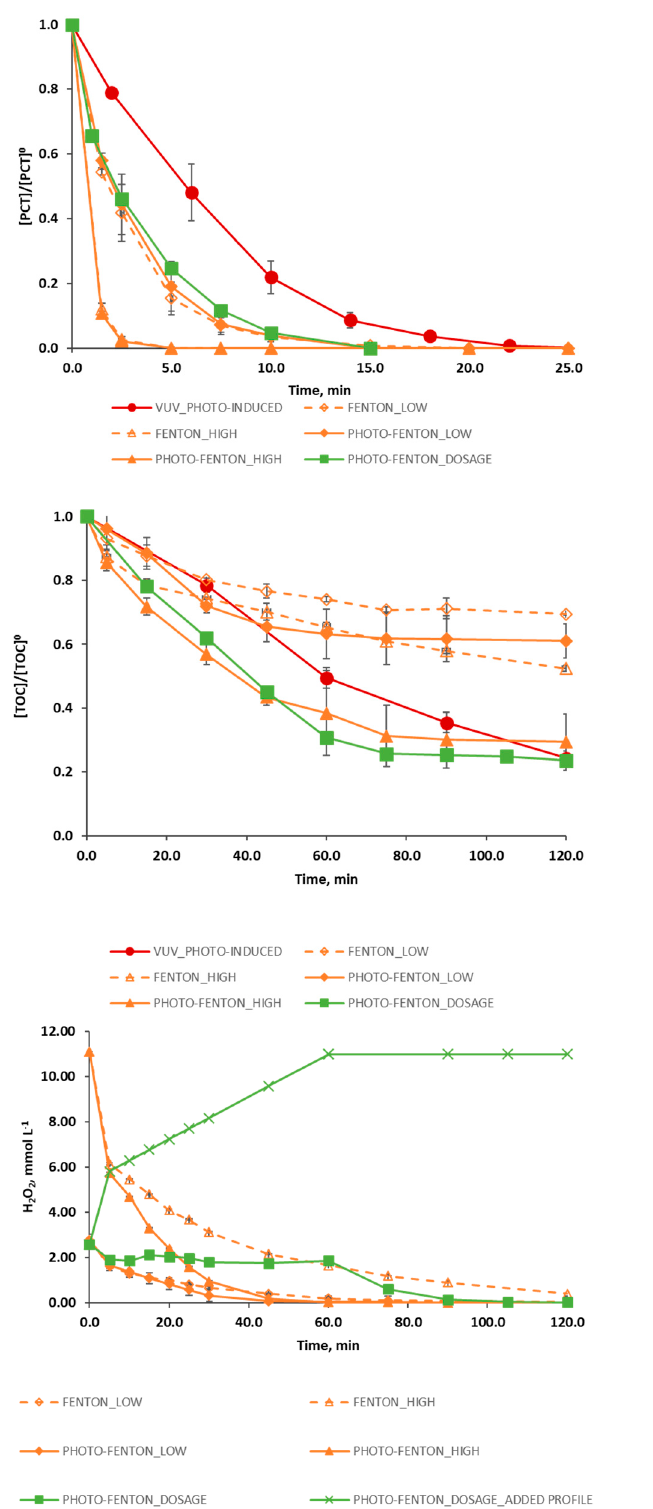
Figure 2. Evolution of the degradation of ( a ) PCT (normalized values), ( b ) TOC (normalized values) and ( c ) H 2 O 2 (concentration, mmol L − 1 ) for different process: photo induced advanced oxidation ( • ); Fenton, using low and high concentrations of Fenton reagents ( ◊ , ∆ ); photo-Fenton using low and high concentrations of Fenton reagents ( ♦ , ▲ ); and photo-Fenton process following a H 2 O 2 dosage strategy ( ■ ). Figure 2c also shows the profile of the added hydrogen peroxide during the reaction span (concentration values, mmol L − 1 ). The error bars display the standard deviation for the set of three experiments.